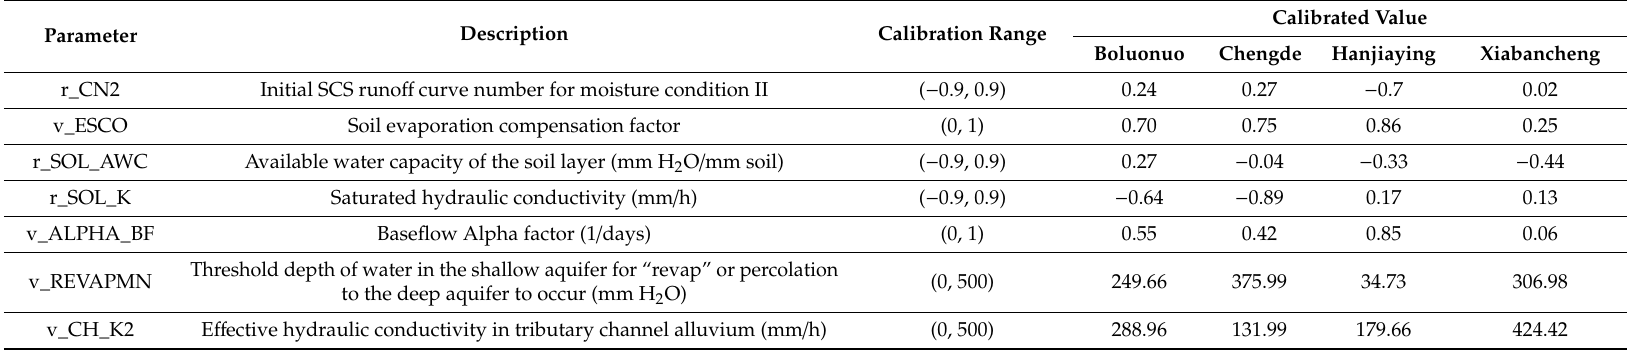
Table 2. The calibrated values of the model